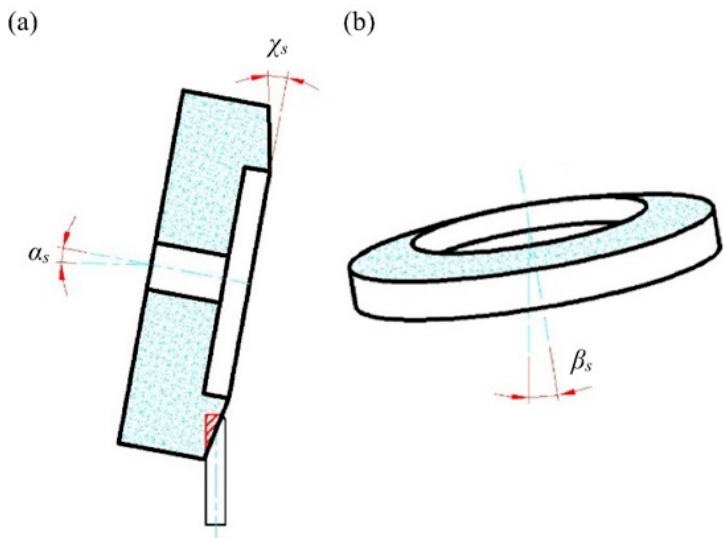
Figure 3. Diagram of the angular positioning of the grinding wheel in three planes with respect to the planar blade: ( a ) side view; ( b ) front view (angle values used in the described tests: α s = 85°, β s = 5°, χ s = 20°).